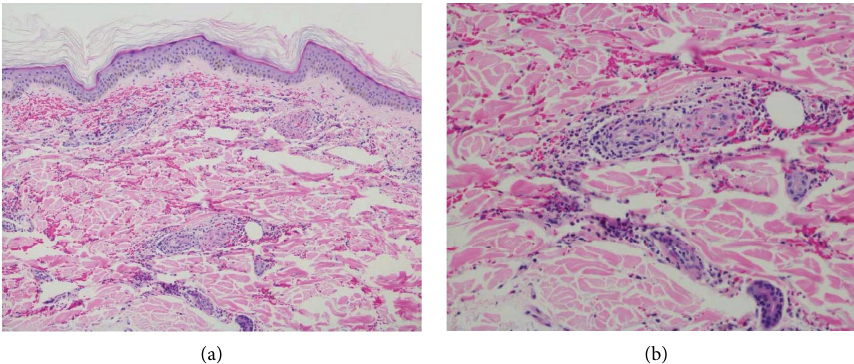
Figure 2: (a, b) 100x low-power image (a) and 200x medium-power image (b) showing extravasation of erythrocytes, perivascular infltrate of neutrophils, nuclear dusts, and eosinophils, and features of leukocytoclastic